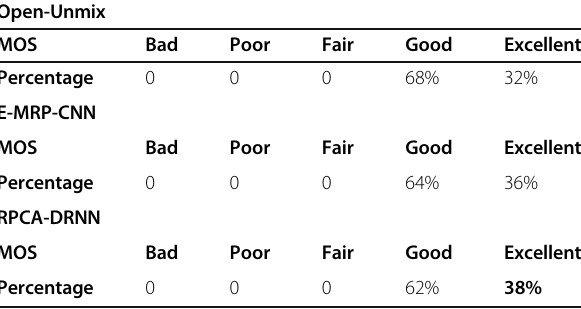
Table 8 Percentages of bad, poor, fair, good, and excellent MOS scores assigned to singing voice clips separated using